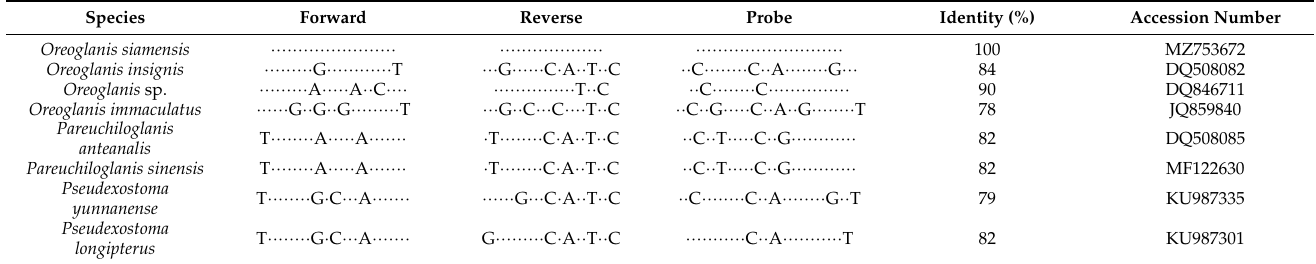
Table 2. Homology of the query to the primers and probe and percentage identity as a function of the number of matching base sites divided by 69 (total number of base sites across the primer pair and probe). The base site homology between the query and the primer is shown as a dot.